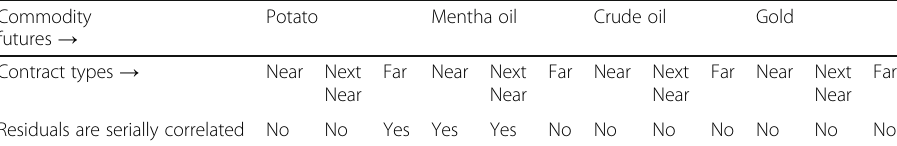
Potato Mentha oil Crude oil Gold Far Near Next Far Near Next Far Near Next Far Near Near Near Near